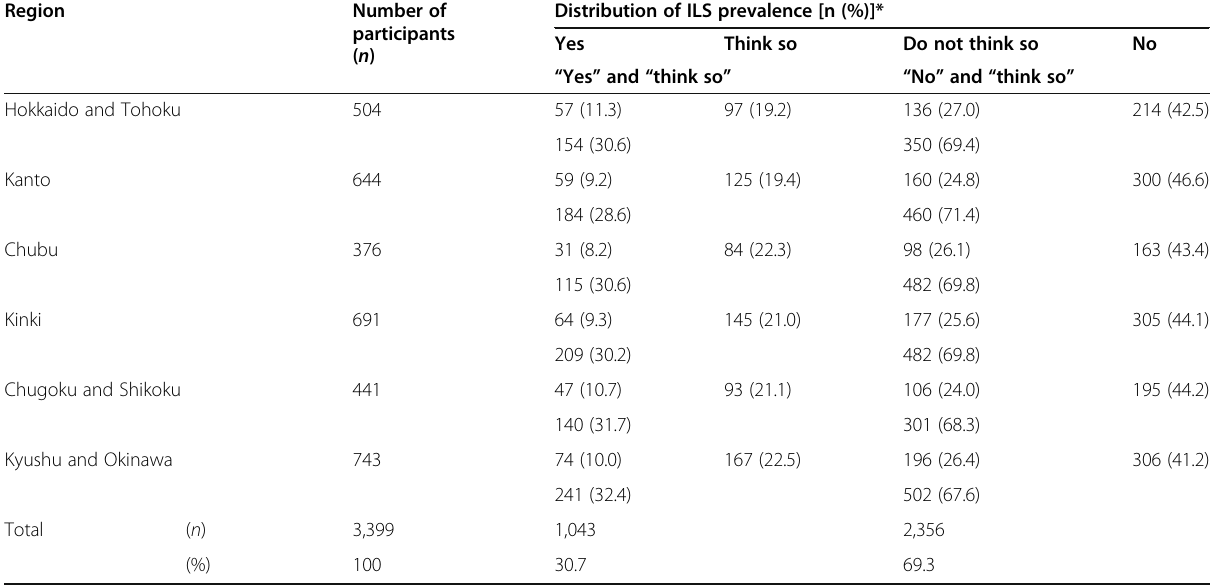
Table 4 ILS prevalence in Japan, stratified by region Region Number of